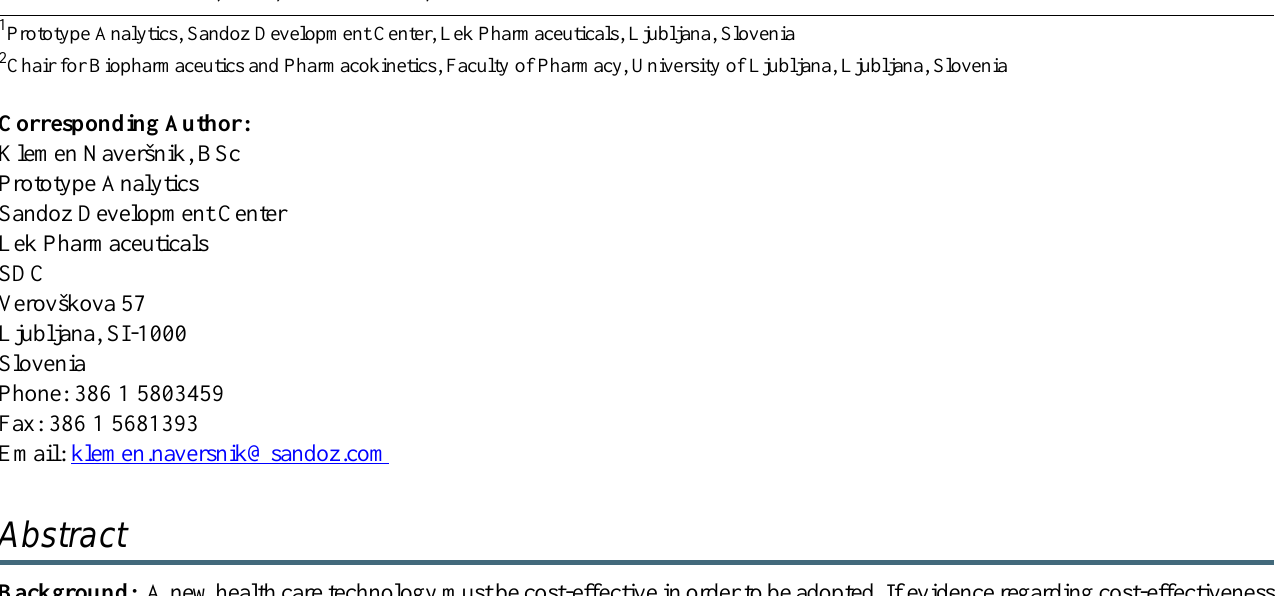
depression; medical economics; value-based